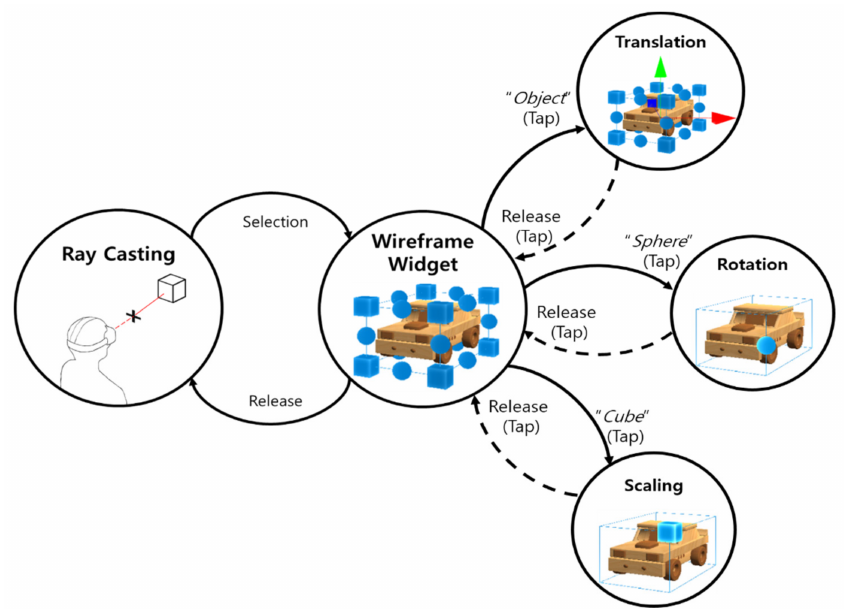
Figure 2. Flow diagram of virtual object